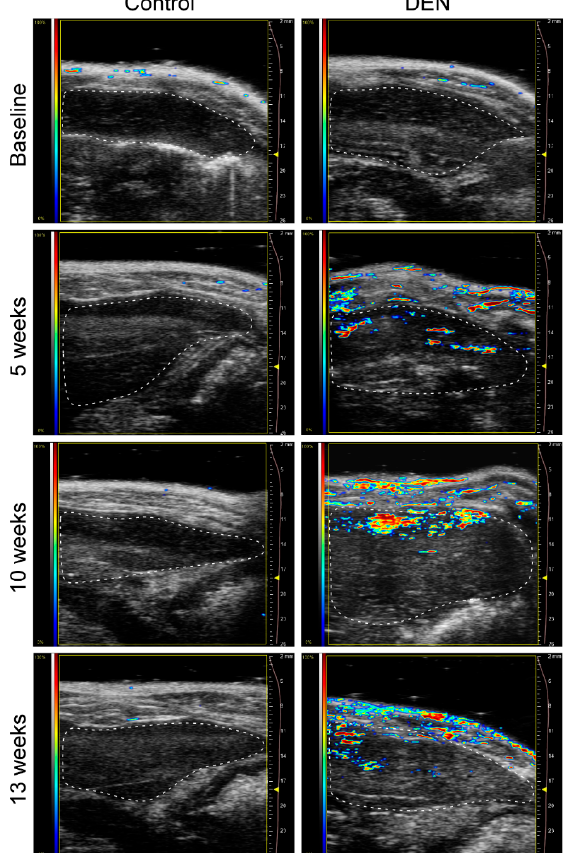
Figure 1. PA (photoacoustic) images of the livers of the control versus DEN (diethylnitrosamine) ‐ ingested rats. The PA signals obtained are superimposed on the sagittal ultrasound images of the left liver lobe, the borders of which have been outlined. PA signal acquired from the OxyHemo mode measures PA signal at two wavelengths, 750 nm and 850 nm. PAI (photoacoustic imaging) quantifies and maps hemoglobin concentrations from the optical absorption coefficients and molar extinction coefficients of the oxygenated and deoxygenated hemoglobin at the given wavelength. The total hemoglobin concentration and oxygen saturation are derived from oxygenated and deoxygenated hemoglobin concentration. The displayed images were acquired in the OxyZated mode of the Vevo LAZR platform and represent oxygen saturation. At baseline, the image was made prior to the ingestion of DEN; images were obtained 5, 10, and 13 weeks respectively after DEN administration. The deep red color in the color bar represents the highest (100%) and deep blue color the lowest (0%) PA signal. Note the qualitative increases in PA signals following DEN therapy and onset of hepatic fibrosis. Control rats showed no increase in PA signals over time.